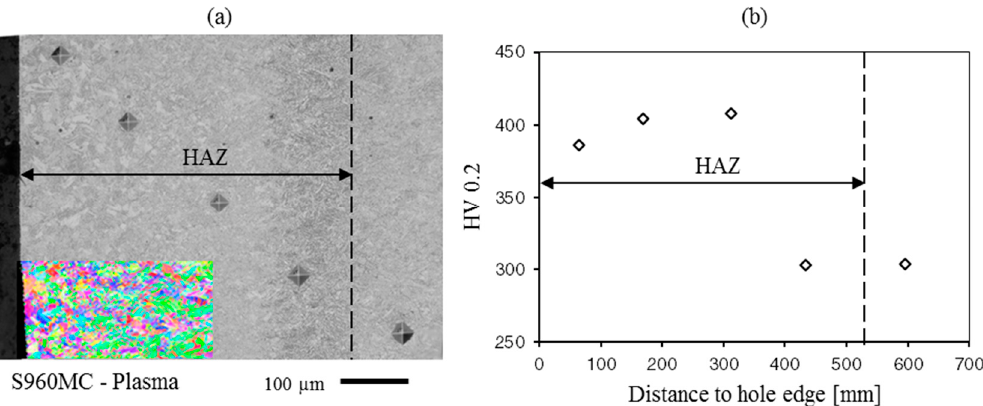
Figure 13. Hardness analysis near S960MC plasma layer: ( a ) micrograph displaying hardness measurements, ( b ) hardness values vs. distance to hole edge for each measurement.